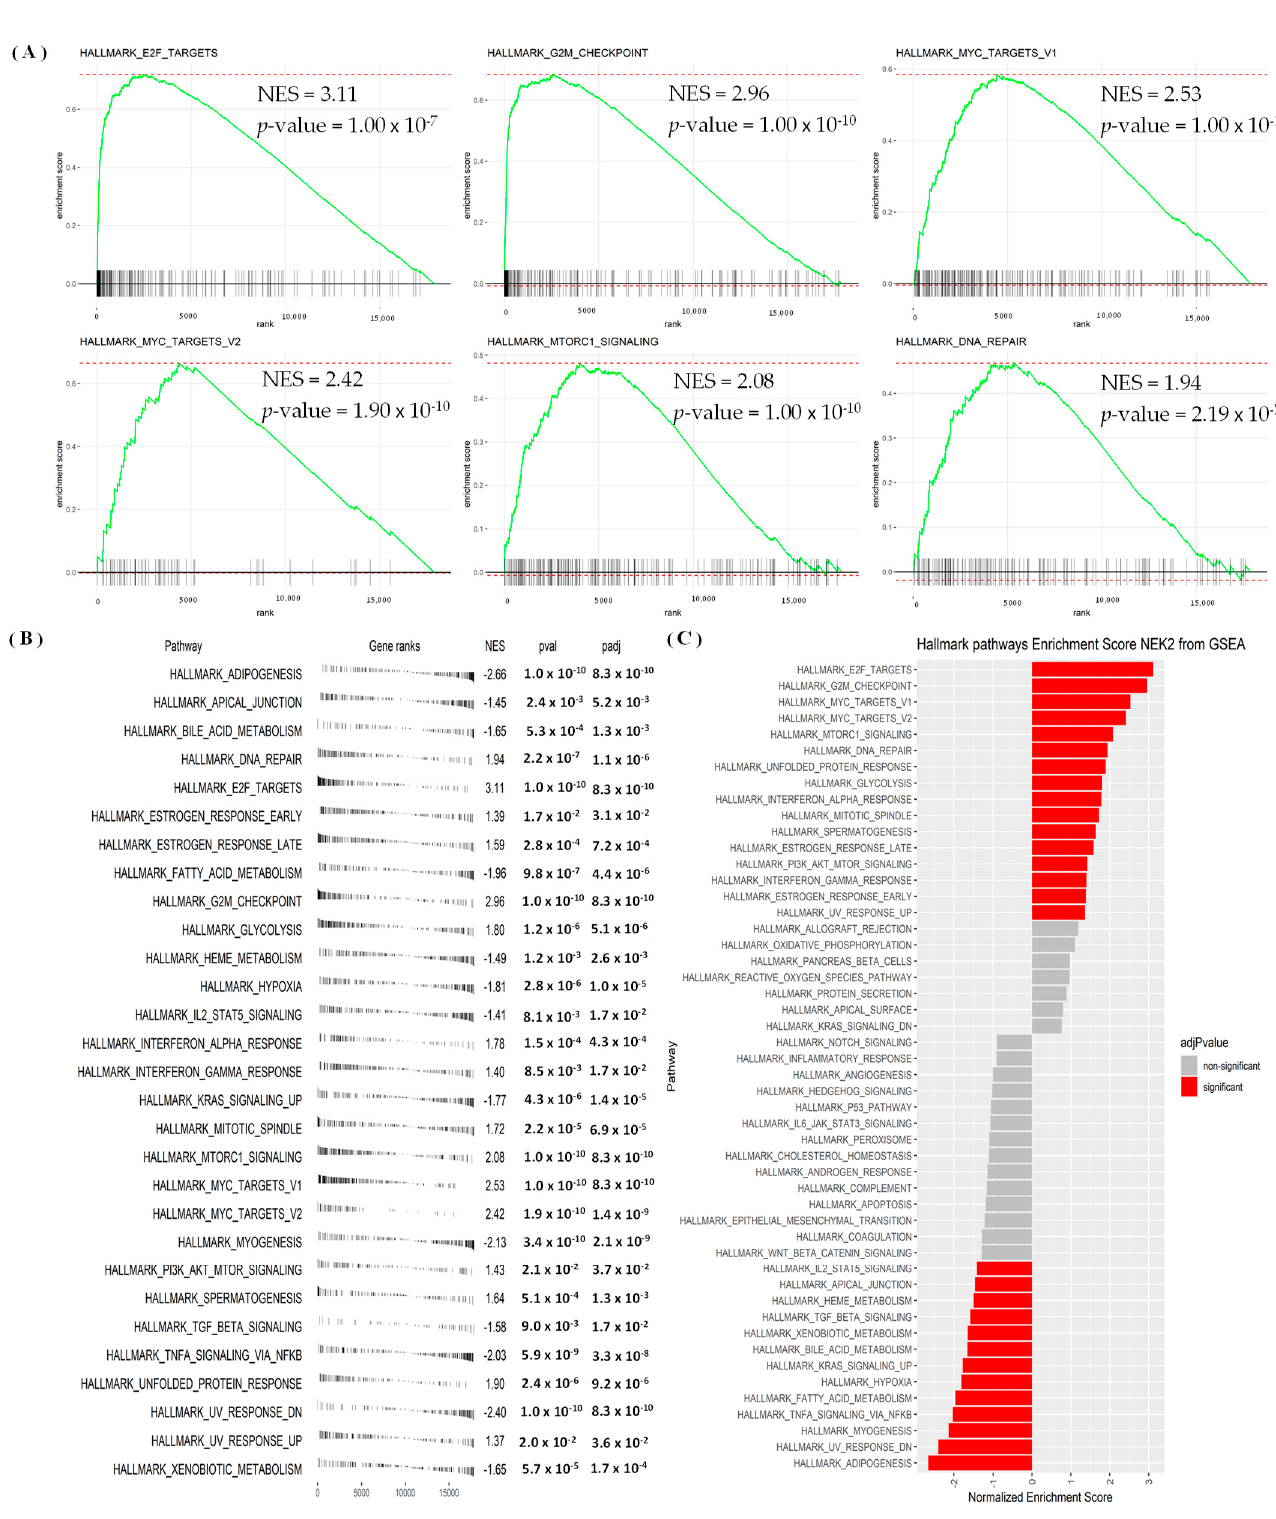
Figure 7. ( A – C ) Hallmark signaling pathway analysis of NEK2 in breast cancer. We used median expression of the NEK2 gene (high and low expression) and then performed a differential analysis using the algorithm in the “DESeq2” package in R/Bioconductor. Furthermore, results of the differential analysis were used as input for the gene set enrichment analysis (GSEA) with the Hallmark database, and computationally used the “fgsea” package in R/Bioconductor. Results of the analysis show significant values of gene classes in the Hallmark database. The level of statistical significance is shown through the p -value, and the normalized enrichment score (NES) reflects the rank of gene classes in the database.